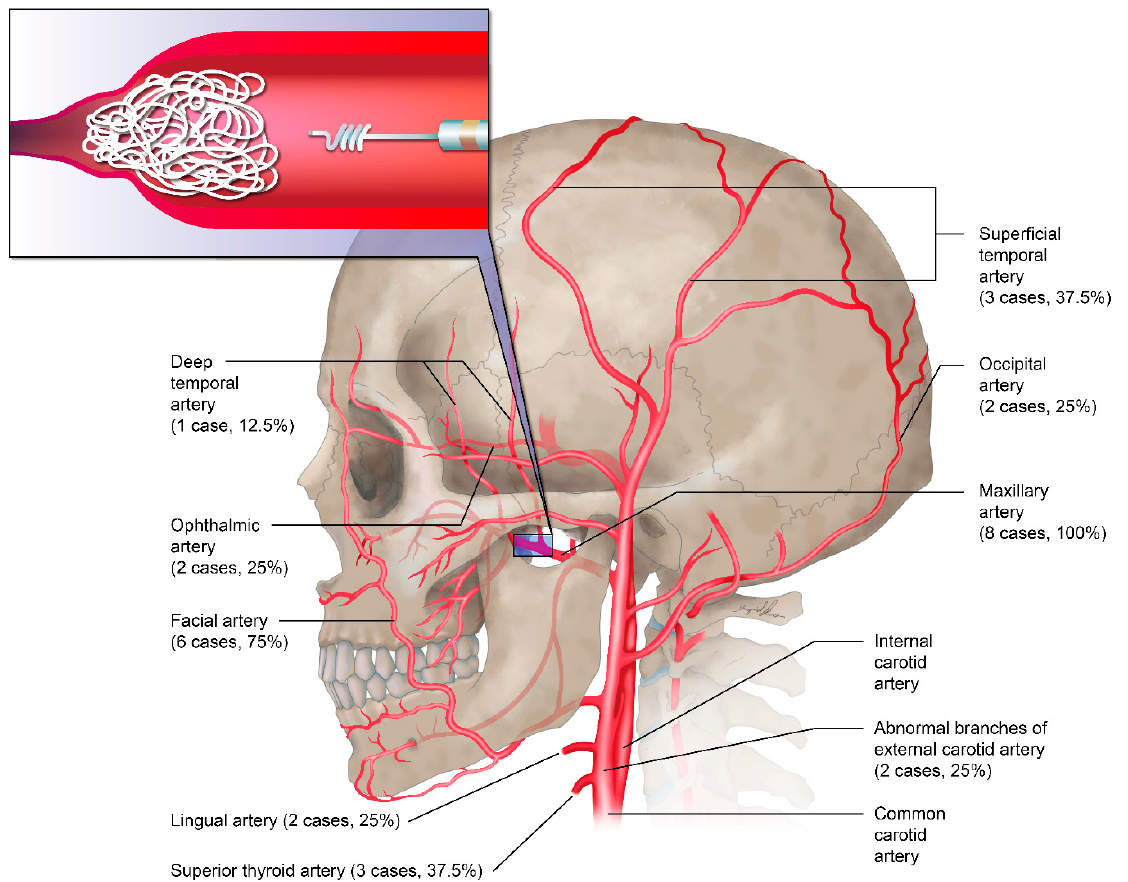
Figure 2. Target vessels of preoperative transarterial embolization ( n = 8).